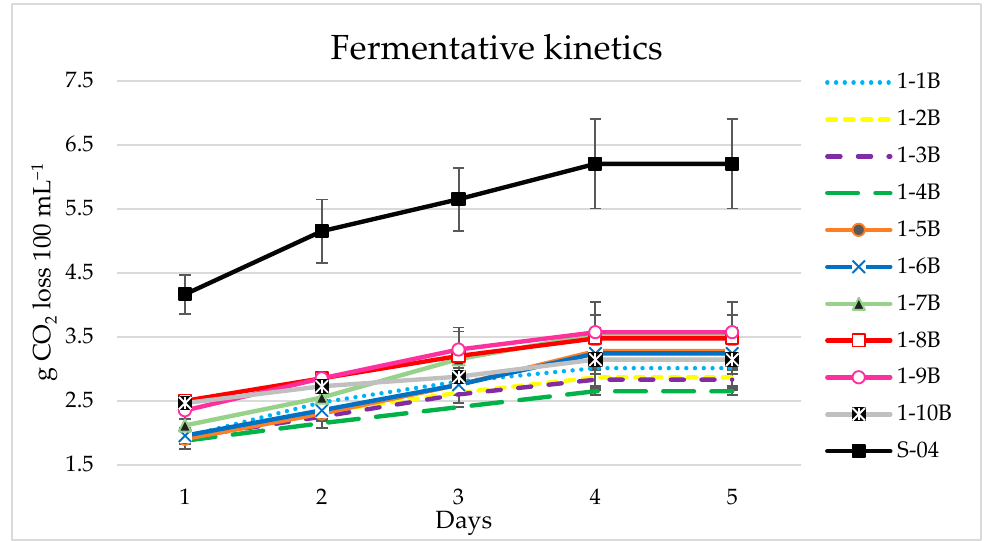
Figure 1. Fermentative kinetic of 10 L. thermotolerans strains fermented in 100 mL to obtain sour beer.